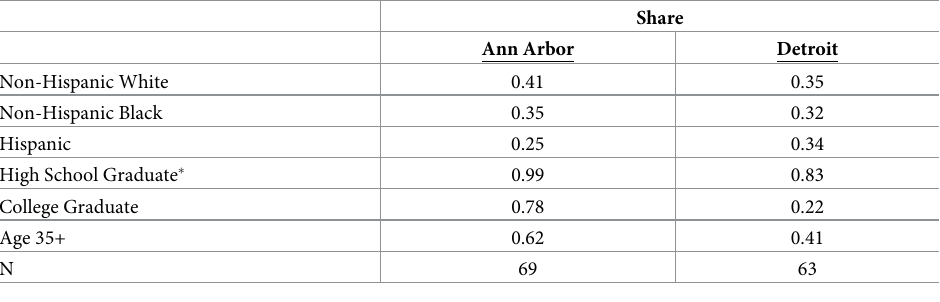
Table 1. Characteristics of Ann Arbor and Detroit